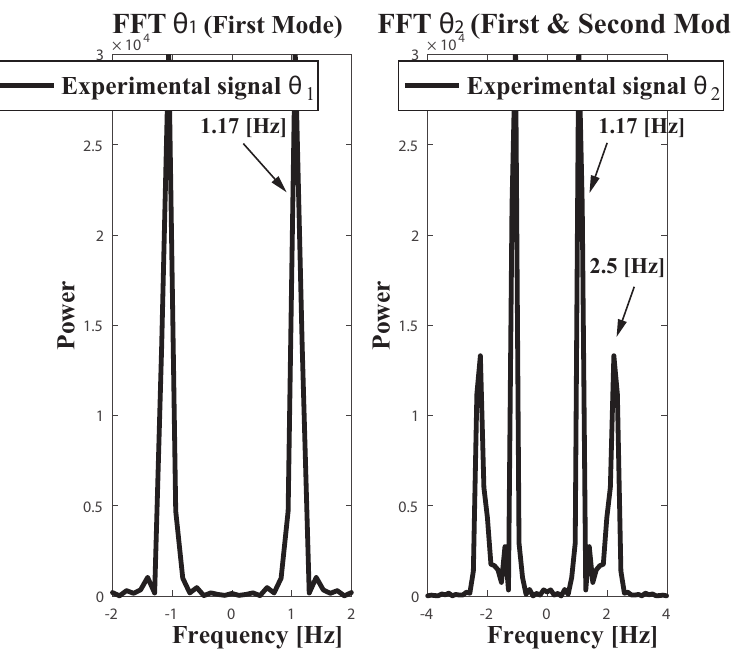
Figure 9. Fast Fourier Transform (FFT) of the experimental dynamic signals θ 1 ( t ) , θ 2 ( t ) . Conditions: sampling frequency 60